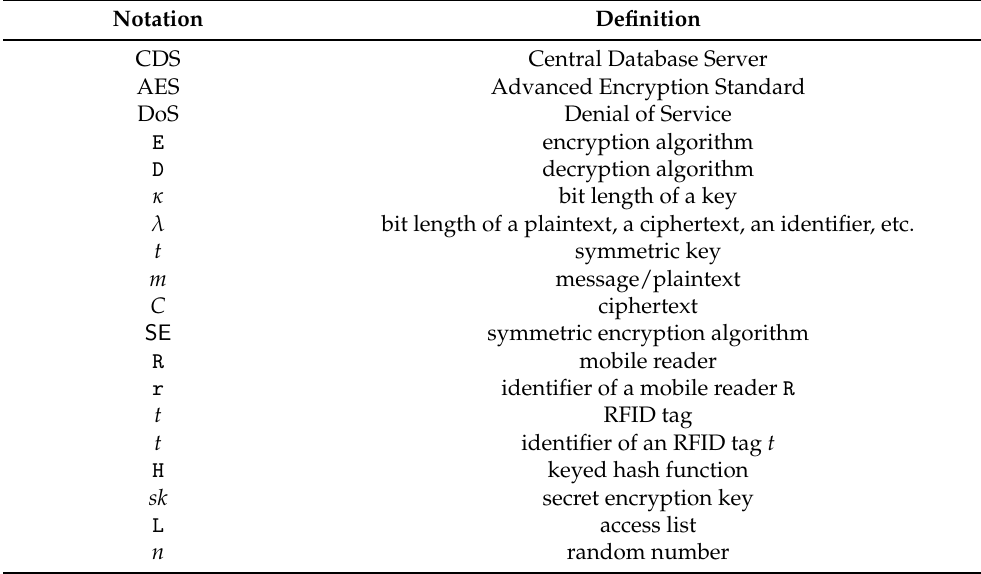
Table 1. Description of